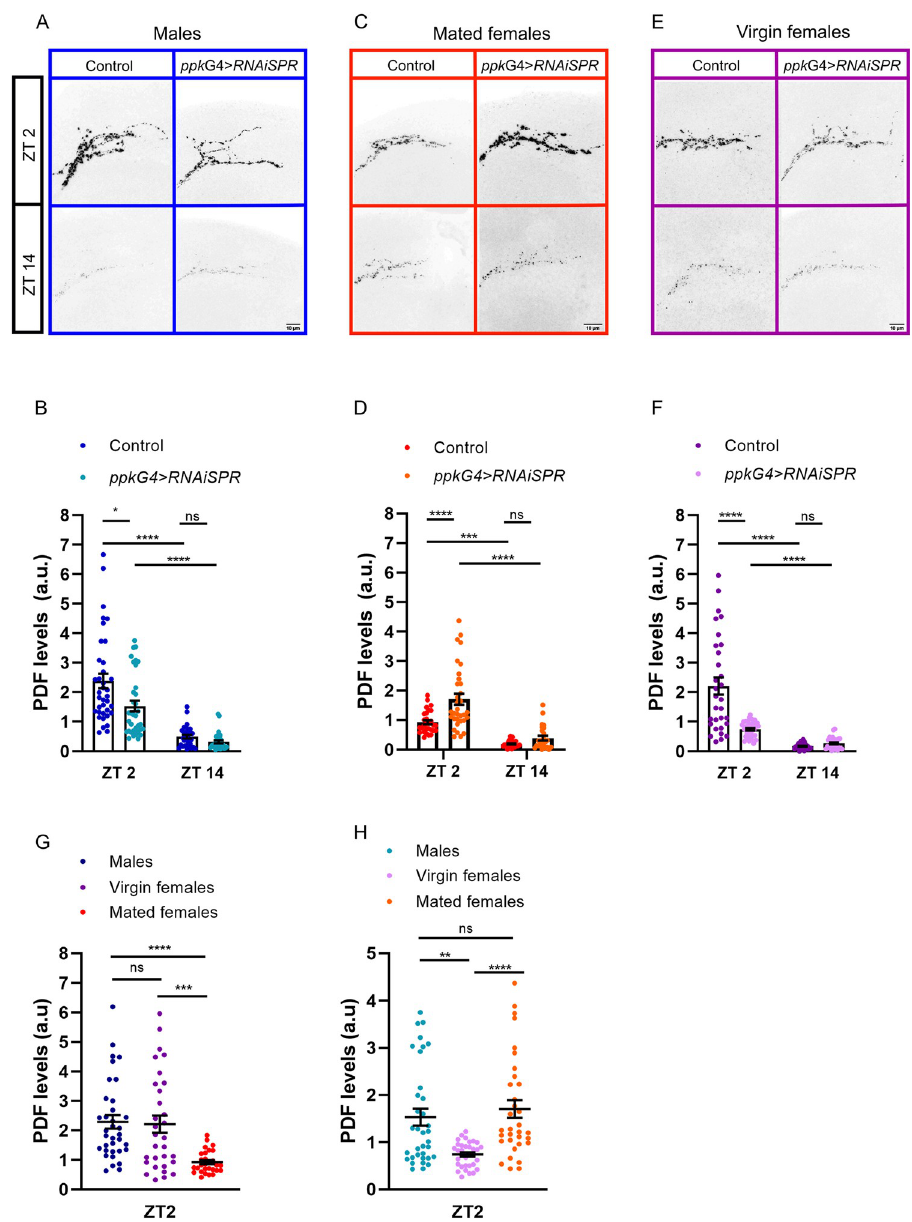
Fig 5. PDF levels are reduced in mated females ( A , C , E) Confocal images of representative sLNv dorsal projections of individual male, virgin and mated female flies showing their PDF content during the day (top) and night (bottom). Left: control flies (UAS- Dicer 2, SPR-IR1 > +). Right: flies with SPR downregulated in ppk+ neurons ( ppk- Gal4 > UAS- Dicer2 , SPR-IR1 ). Brains were dissected at ZT02 and ZT14 and standard anti-PDF immunofluorescence detection was performed. The bar indicates 10 μ m. ( B , D , F ) PDF quantitation of the sLNv dorsal projections for the twelve conditions mentioned above. Dots represent individual brains. B , Males (n = 31–37); D , Mated females (n = 26–33), F , Virgin females (n = 27–33). Two-way ANOVA with Tukey’s post hoc tests. (G and H) Quantification of PDF signal intensity at day (ZT02) of control (UAS- Dicer 2, SPR-IR1 > +) and SPR downregulation in ppk+ neurons ( ppk- Gal4 > UAS- Dicer2 , SPR-IR1 ) respectively. Kruskal-Wallis test with Dunn’s multiple comparisons test, p < 0.0001. Statistically significant differences were represented as � p < 0.05, �� p < 0.01, ��� p < 0.001, ���� p < 0.0001. ns, not significant.